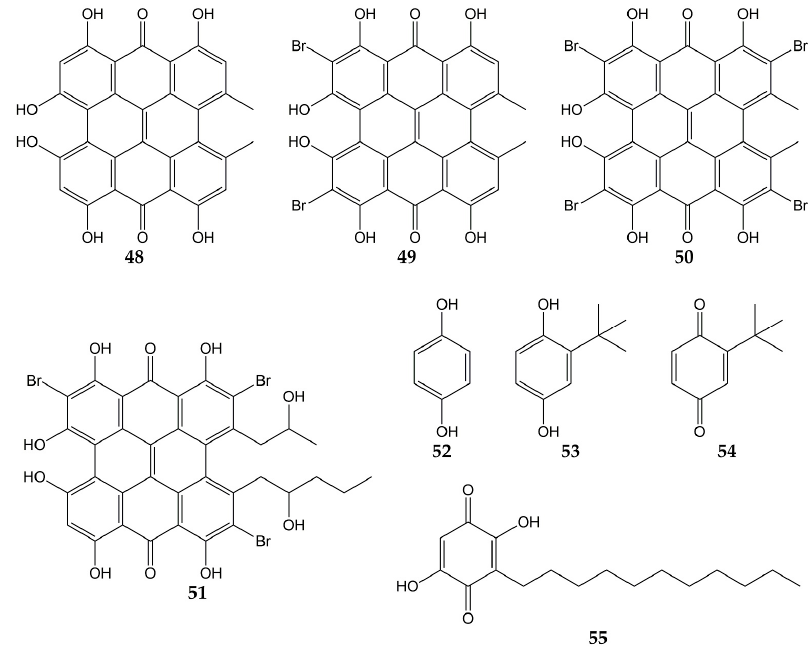
Figure 6. Chemical structures of quinones 48 – 55 . In this sense, hypericin ( 48 ; an aromatic polycyclic anthrone present in Hypericum triquetrifoliurn ) exhibited a virucidal effect against influenza virus A/Brazil at concentra- tions ranging from 3.12 to 50 µg/mL [121]. Compound 48 and its analogs dibromohyperi- cin ( 49 ), tetrabromohypericin ( 50 ), and gymnochrome B ( 51 ) were evaluated against the influenza A virus. All molecules showed antiviral activity, with minimum 100% inhibi- tory concentrations (MIC 100 ) of 13 ( 48 ), <5 ( 49 ), 250 ( 50 ), and 78 nM ( 51 ) [122]. Other quinone derivatives with antiviral activity are hydroquinones, particularly 1,4- hydroquinone ( 52 ). This compound was isolated from the leaves of Elaeocarpus tonkinensis (a medicinal plant from Vietnam that belongs to the Elaeocarpaceae family) and inhibited the activity of influenza viruses A/PR/8/34 (H1N1), A/HongKong/8/68 (H3N2), and